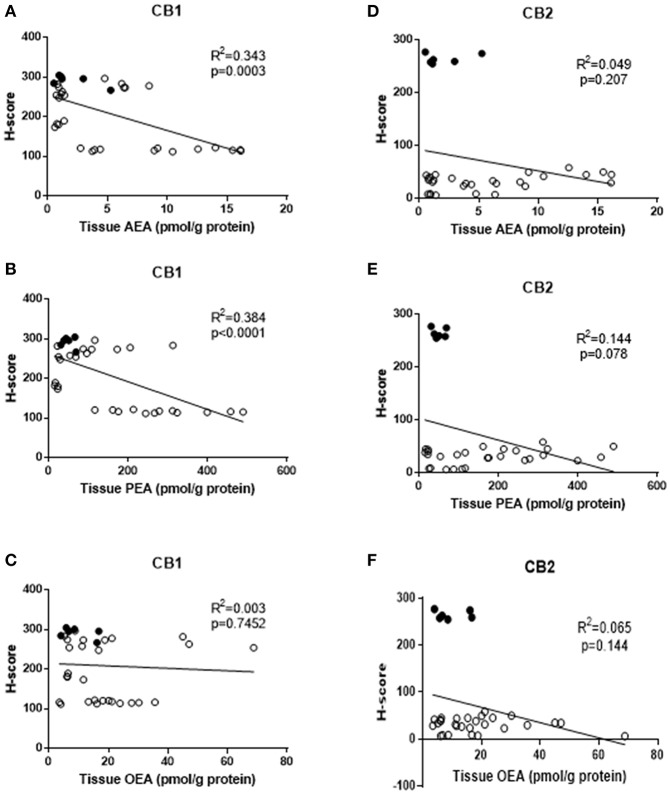
Correlation between tissue levels of AEA, PEA, and OEA with tissue protein expression levels. The relationships between tissue levels of AEA and CB1 or CB2 protein (A,D), tissue levels of PEA and CB1 and CB2 protein (B,E) and OEA and CB1 or CB2 protein (C,F) are shown. The data for atrophic controls (n = 6) are shown by filled circles and those for the EC patients (n = 28; 24 Type 1 and 4 type 2 EC) by open circles. The indicated R2 and p-values were obtained using Pearson correlation analysis.